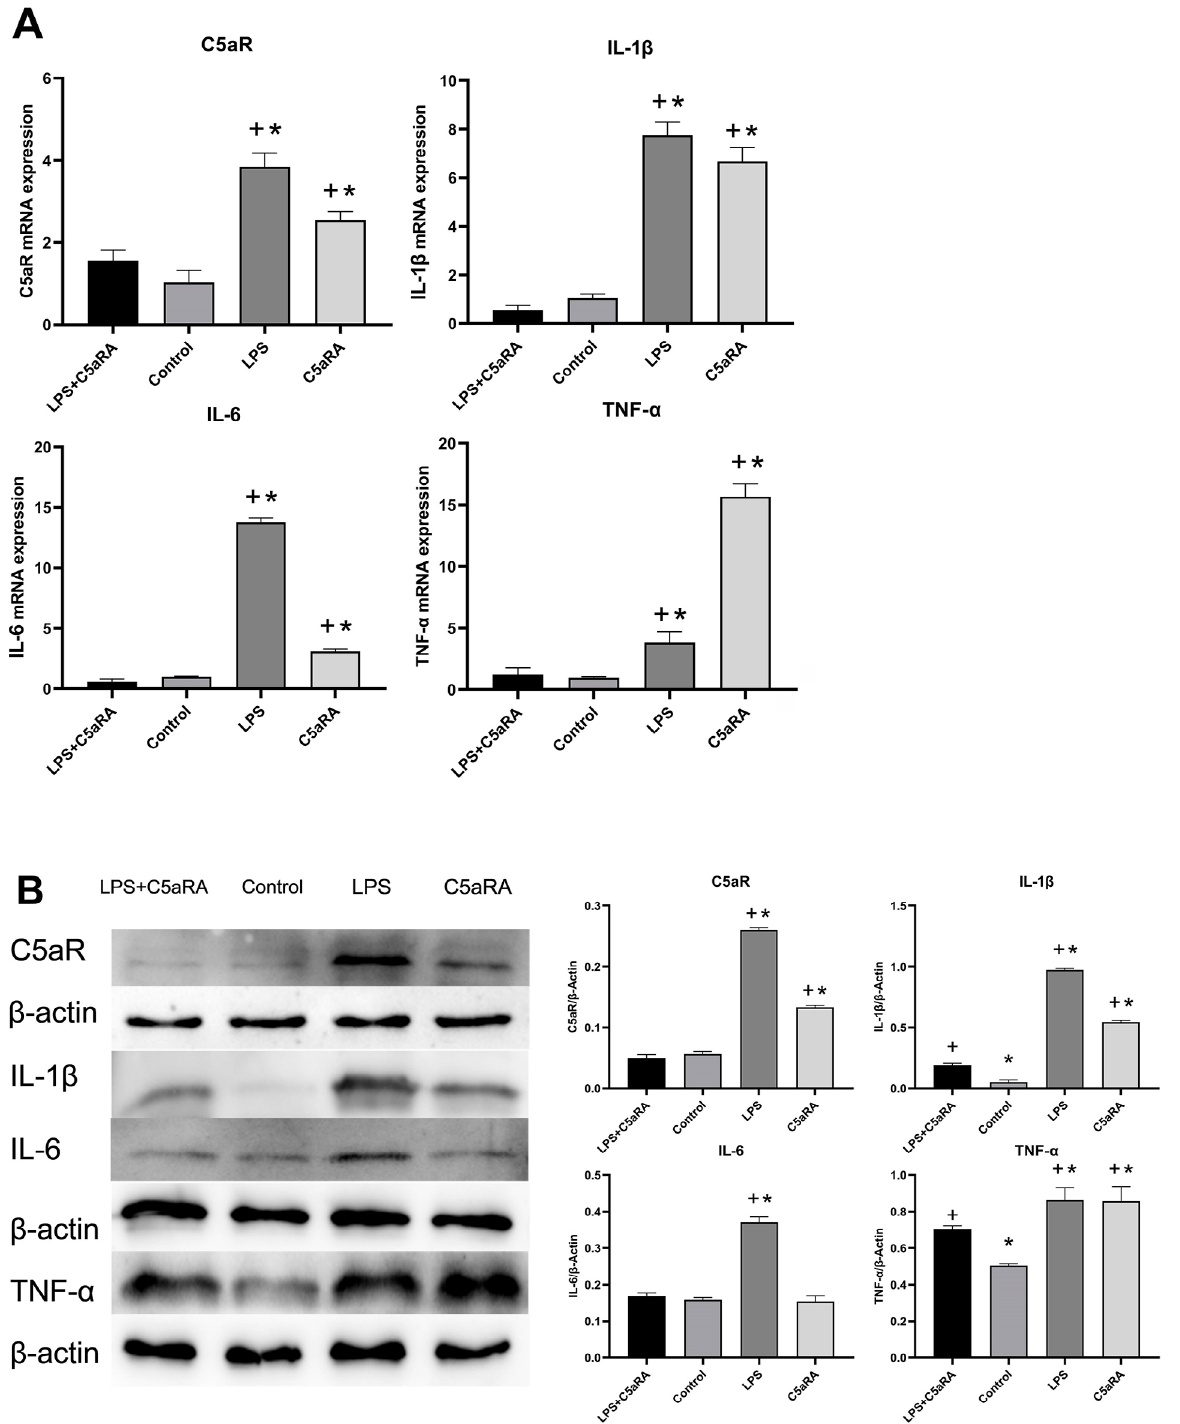
Figure 5- Effects of C5aRA on the expression of C5aR and inflammatory factors of LPS-induced HGFs by RT-qPCR and Western blotting. (A) C5aRA inhibited expression of C5aR, TNF- α , IL-1β, and IL-6 mRNA in LPS-stimulated HGFs. (B) C5aRA inhibited expression of C5aR, TNF- α , IL-1β, and IL-6 protein in LPS-stimulated HGFs. Data represent the mean ± SEM of three independent experiments. +P < 0.05 vs. the control group. *P < 0.05 vs. the LPS+C5aRA